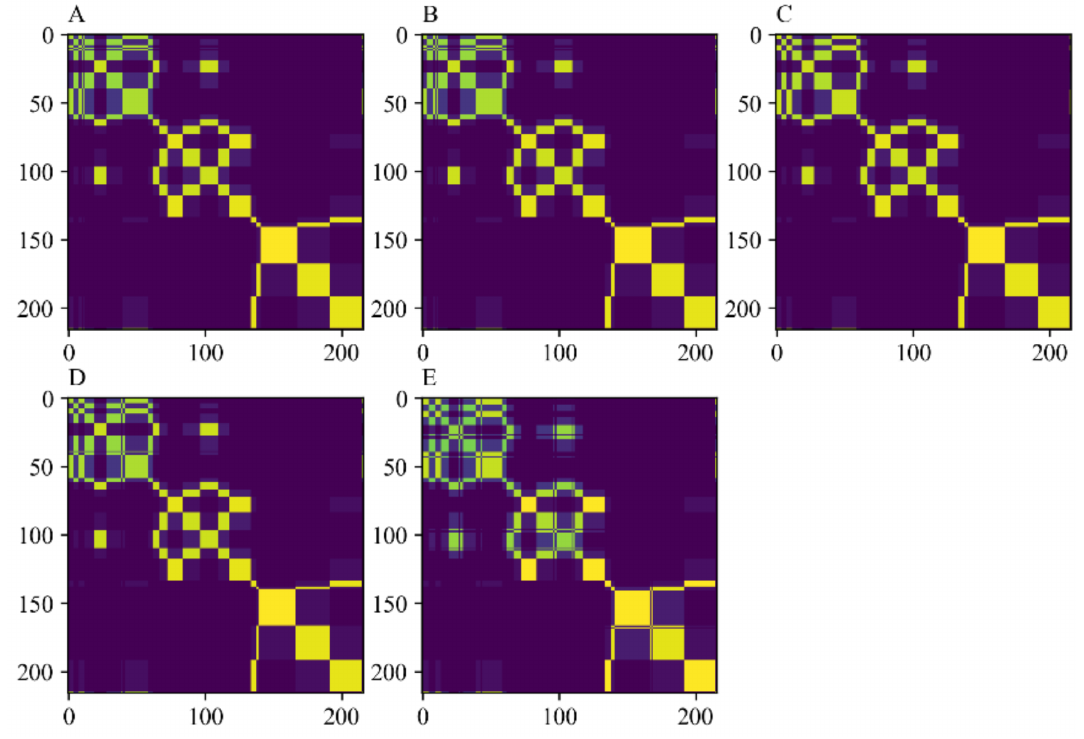
Figure 3. The images of Markov transition field with different noise levels. ( A ) No noise added; ( B ) Add a noise level of 80 dB; ( C ) Add a noise level of 70 dB; ( D ) Add a noise level of 60 dB; ( E ) Add a noise level of 50